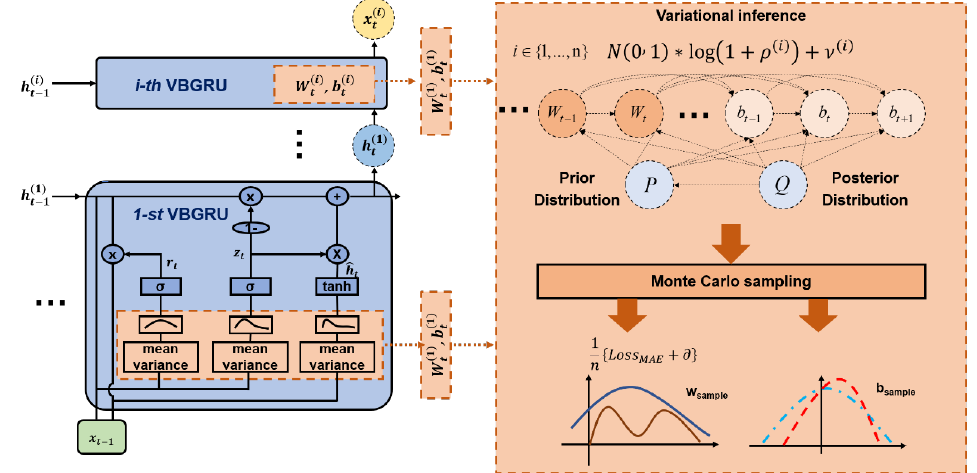
Figure 4. Deep forecasting network. In the lower right corner of the figure, the blue line represents the weight and bias generated by initialization, and the red line represents the new weight and bias sampled from the corresponding mean and variance through the Monte Carlo sampling module.